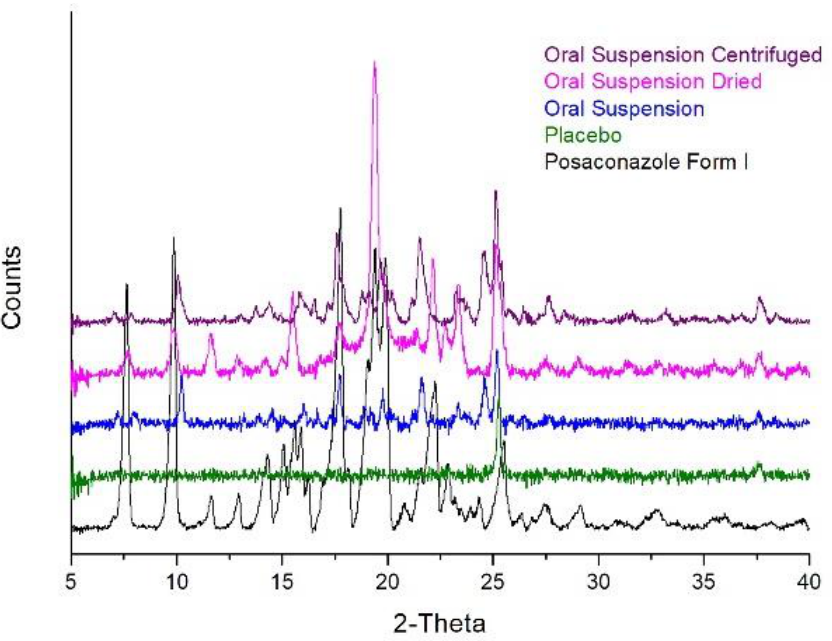
Figure 2. Development of the sample-preparation method for increasing Posaconazole ′ s concentration in oral suspensions: XRPD patterns of Posaconazole oral suspension ′ s precipitate after drying ( magenta line ) and after centrifugation ( purple line ), Posaconazole oral suspension ( blue line ), Posaconazole oral suspension ′ s placebo ( green line ) and Posaconazole Form I (black line).